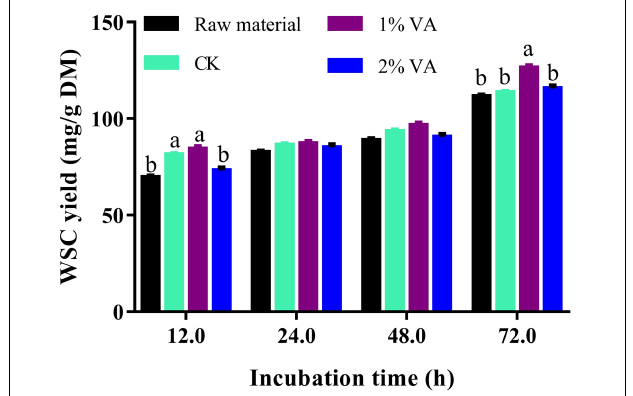
FIGURE 1 | Enzymatic water-soluble carbohydrate (WSC) yield of mature stylo silage (30 days of ensiling) ensiled with the addition of vanillic acid [CK: blank control, 1 and 2%: addition of 1 or 2% vanillic acid. olumns with different letters (a and b) at one time point differ at p <